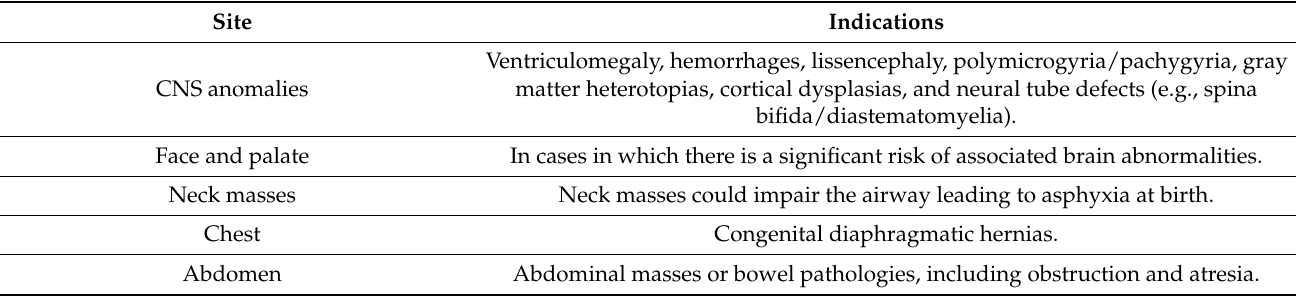
Table 2. Fetal main indications for emergency MRI during